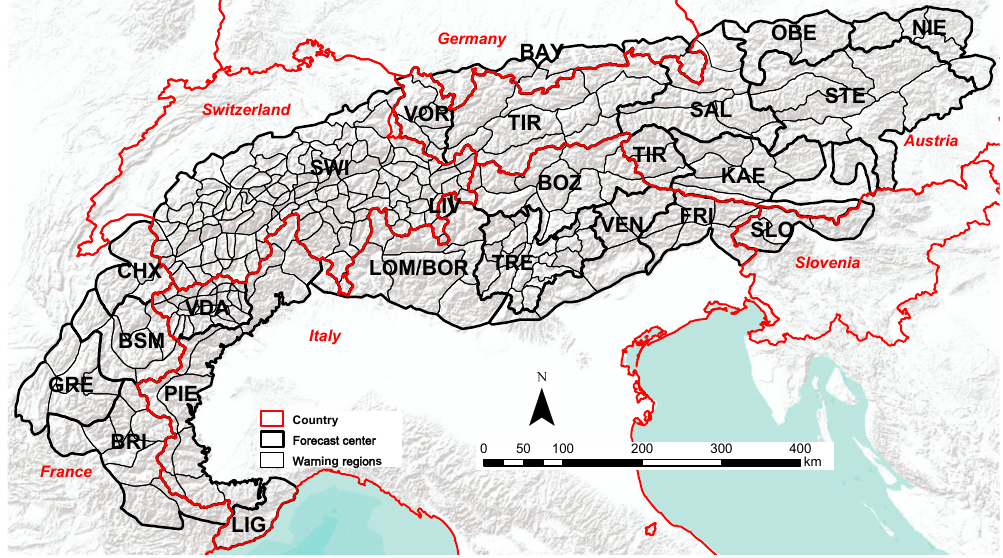
Figure 1. Map showing the relief of the European Alps (gray shaded background) with the outlines of the individual forecast centers (bold black polygons, three-letter abbreviations) and the warning regions, the smallest geographically defined regions, used in the respective avalanche forecasts (black polygons). The borders of the Alpine countries are marked red. In the Italian Alps, where two avalanche warn- ing services provide forecasts (Associazione Interregionale Neve e Valanghe (AINEVA) and Meteomont Carabinieri), the warning regions generally follow AINEVA. An exception is Liguria e Toscana (LIG, Meteomont Carabinieri). The forecast domains of LOM (AINEVA) and BOR (Meteomont Carabinieri) are identical; however, the three warning regions for BOR are not shown on the map. The forecast domain LIV is superposed onto parts of LOM/BOR (map source: ESRI, 2017). Note that the map captures the situation and partitioning during the period under